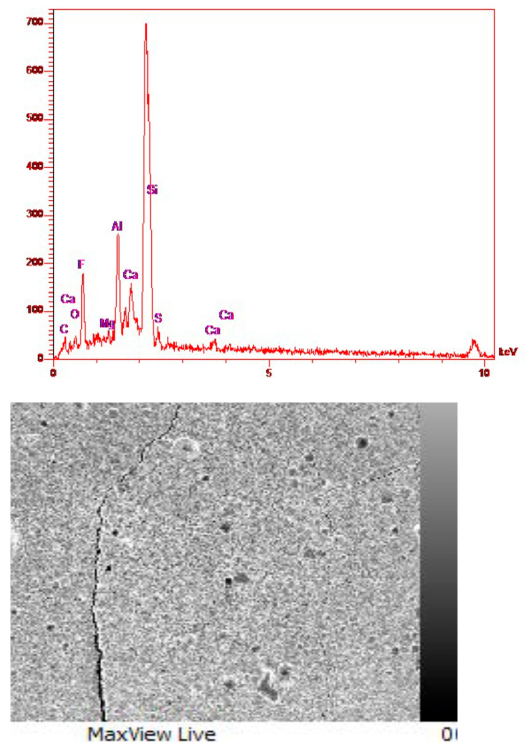
Figure 13. EDS and FESEM analysis of glass ionomer diopside nanocomposite and distribution of elements on the nanocomposite surface.